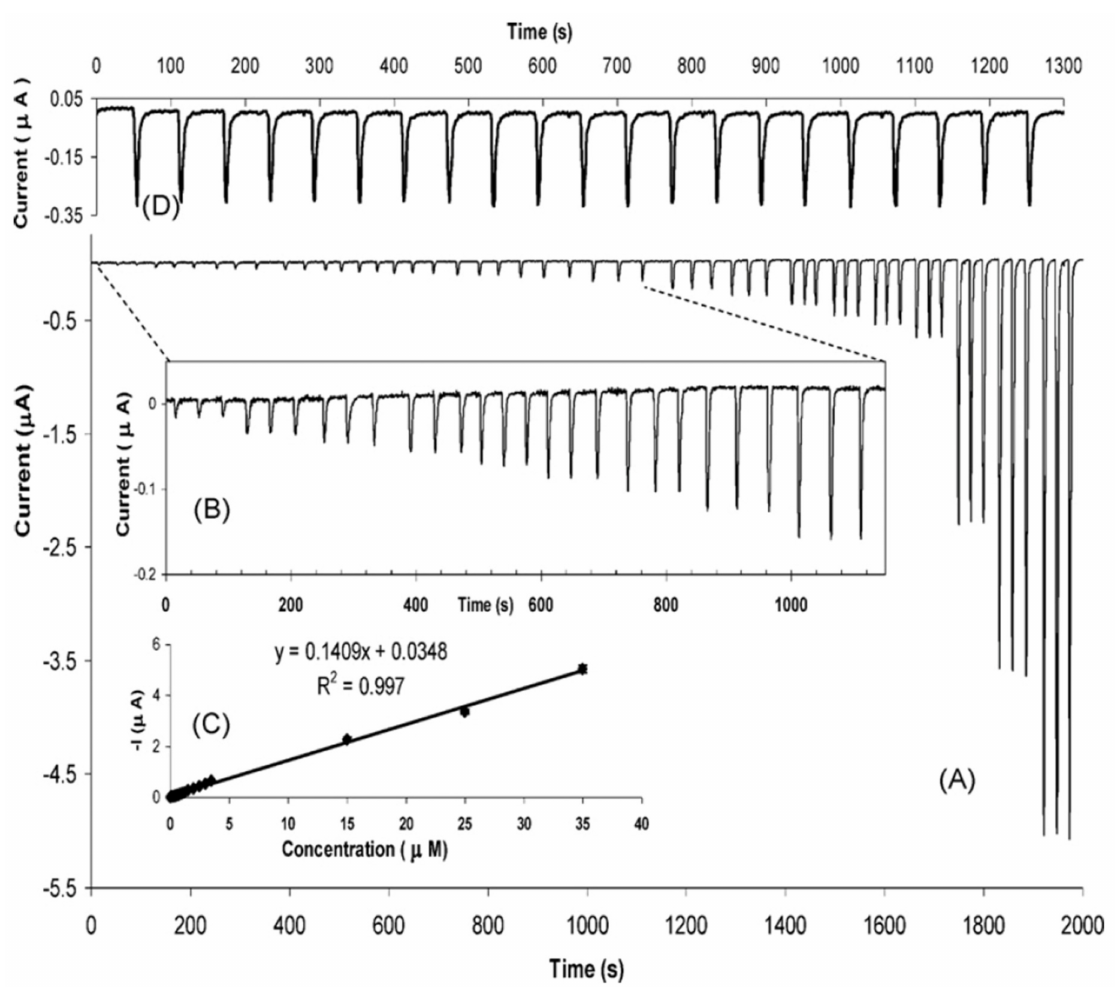
Figure 22. ( A ) Flow Injection Analysis response to 100 nM to 35 µ M of iodate. ( B ) The zoom-in part was corresponding to the low concentration of iodate. ( C ) The calculation curve was based on the FIA. ( D ) The 21 repetitive injections of 1.5 µ M iodates. Reproduced by permission from reference [78]. Copyright 2009 Elsevier